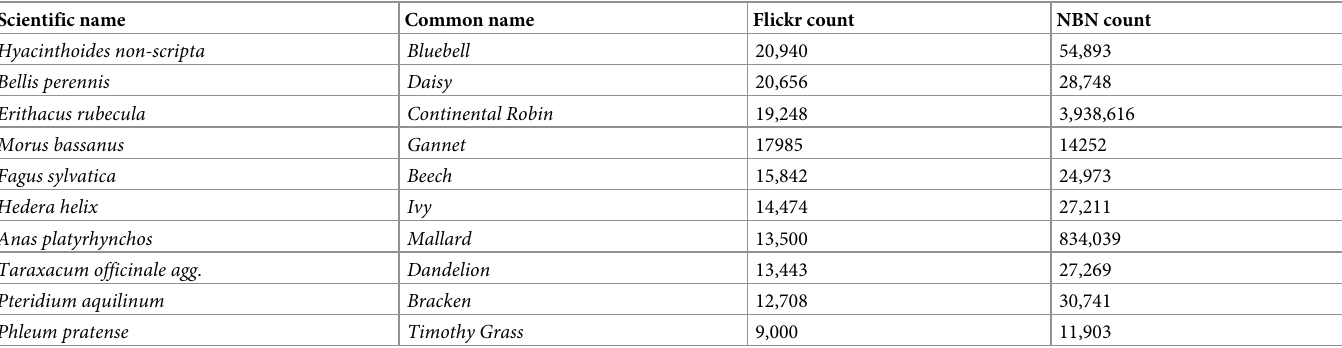
Table 2. The top 10 species on Flickr with the highest number of